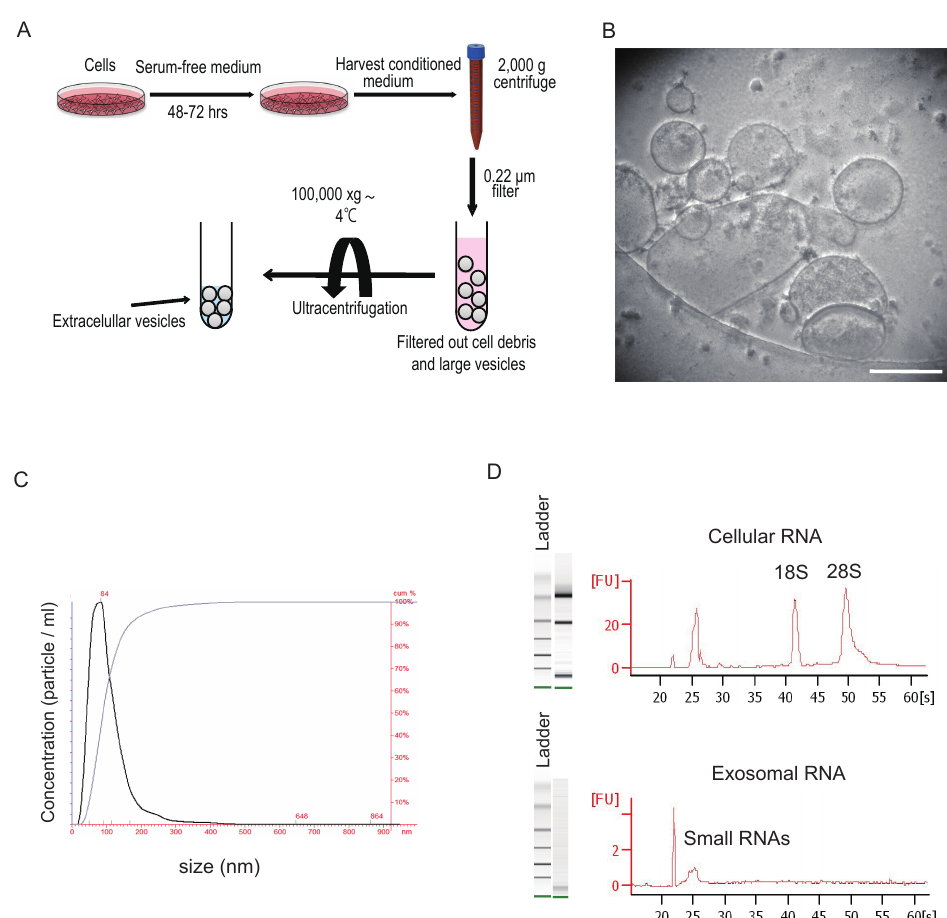
Figure 1. Characterization of EVs isolated by ultracentrifugation. ( A ) Schematic representation of isolating EVs by ultracentrifugation from cultured cells. The method is sufficient to obtain pure EVs for laboratory experiments but it promotes vesicle aggregation and often co-isolate soluble factors and protein. In the clinical setting, it is time-consuming and is not suitable for mass-scale production of EVs. ( B ) Morphology of purified EVs derived from BM-MSCs. Representative phase-contrast transmission electron microscopy images are presented (Scale bar 200 nm). ( C ) Particle size and number determination using NanoSight’s Nanoparticle Analysis instrument (LH10HS) and their proprietary nanoparticle Tracking Analysis software. ( D ) Bioanalyzer analysis of total exosomal RNA by Agilent RNA Pico